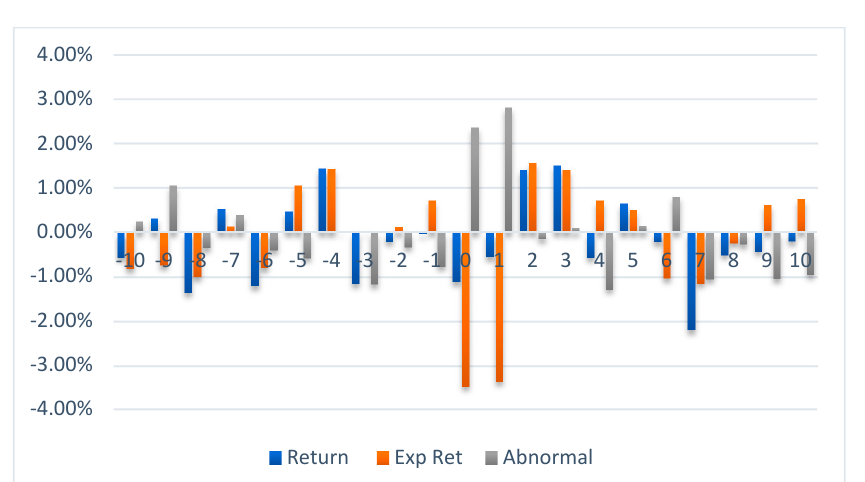
Int. J. Financial Stud. 2018 , 6 , x FOR PEER REVIEW